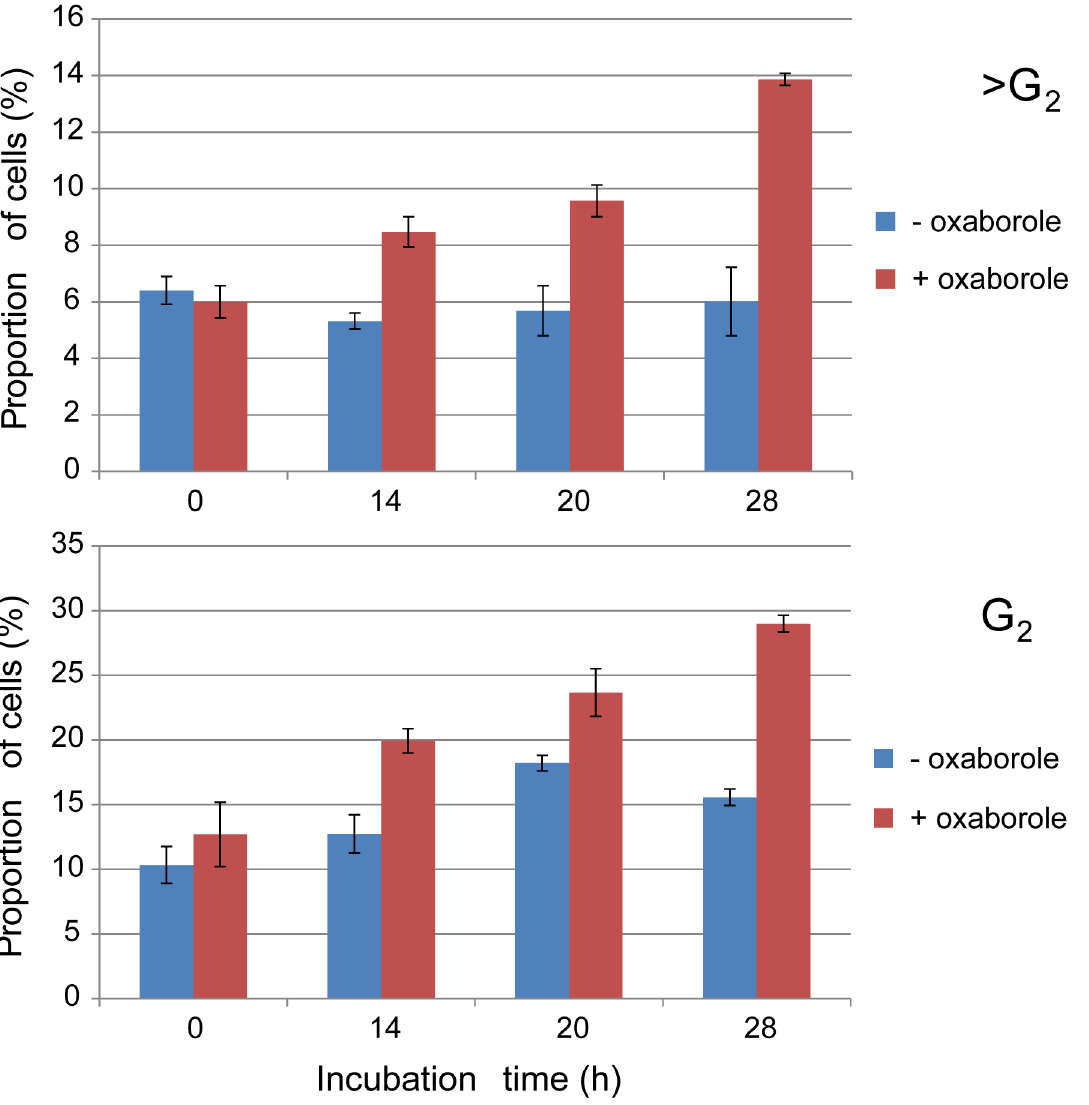
Fig 3. Cell cycle analysis following treatment with